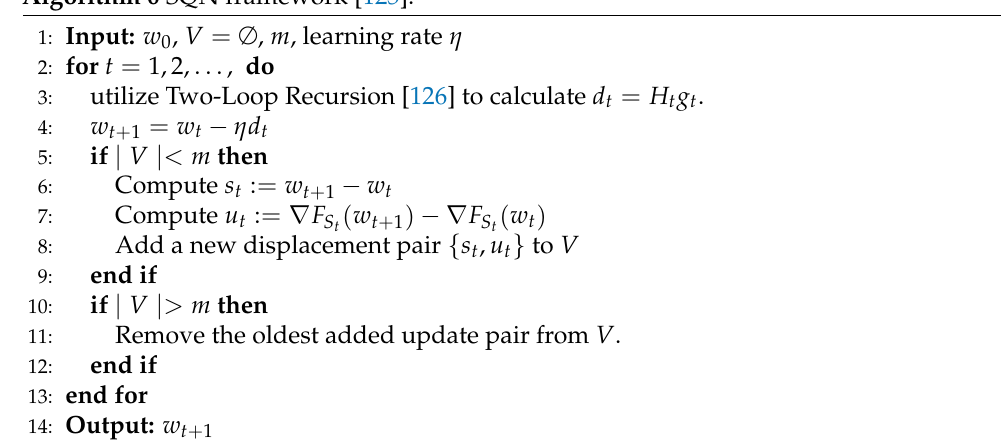
Algorithm 6 SQN framework [125].